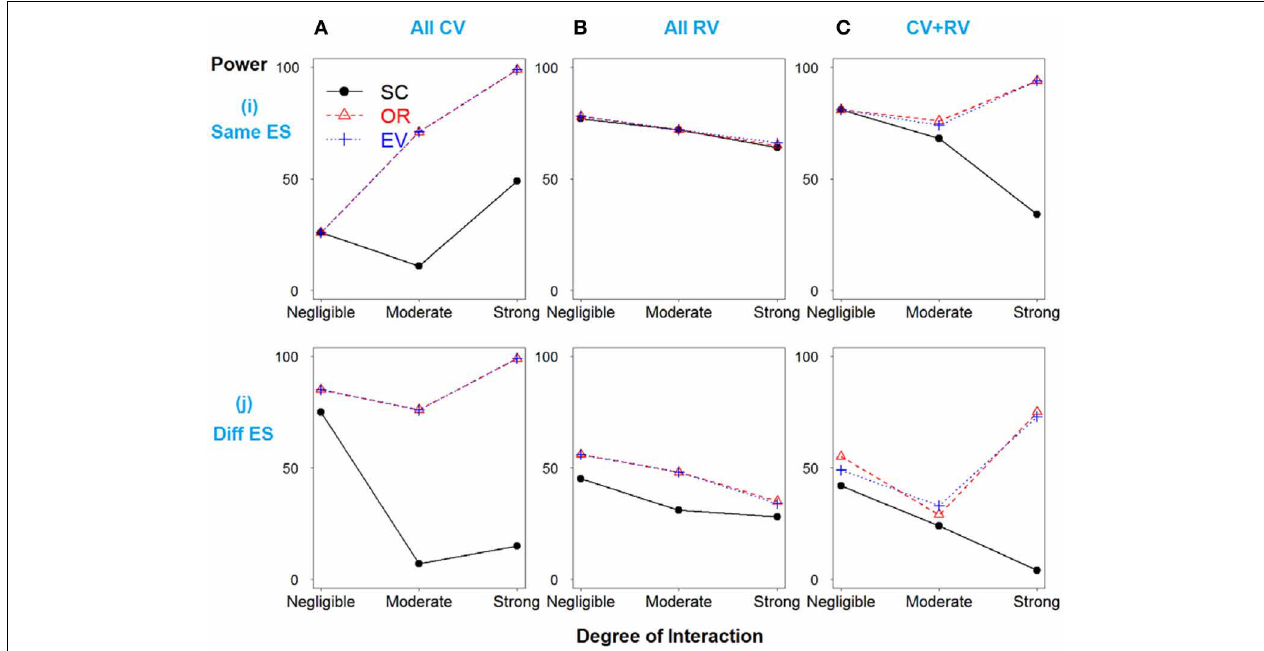
FIGURE 1 | Power comparison for the interaction model with four deleterious SNPs. Panels by column: (A) All SNPs are common variants. (B) All SNPs are rare variants. (C) SNPs 1 and